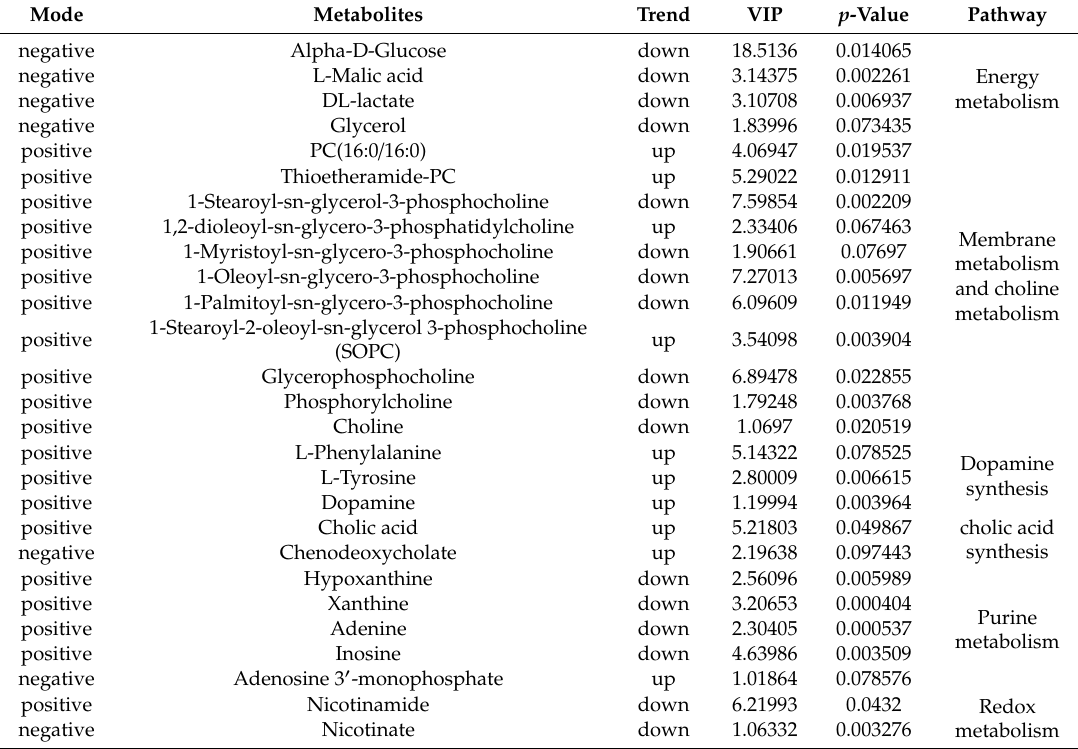
Table 2. Variant metabolites from di ff erent metabolic functions and